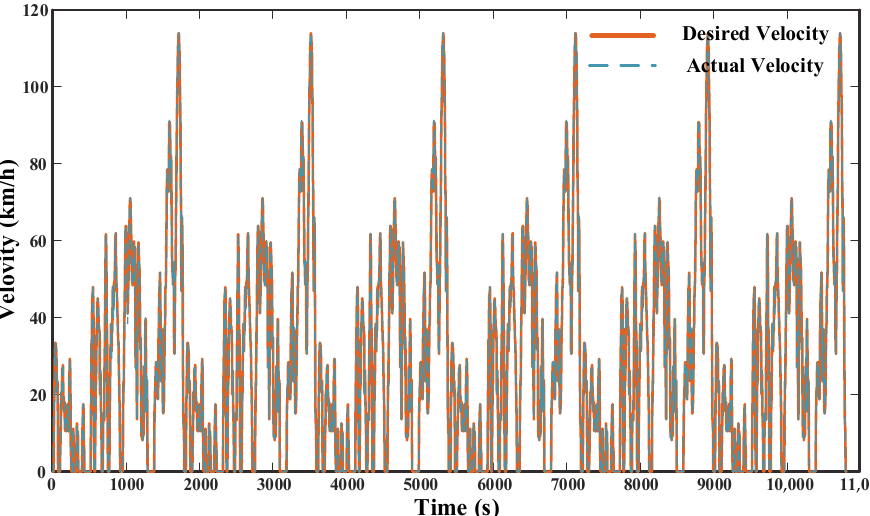
Figure 17. 6*CLTC − P driving cycle and velocity − following curve.